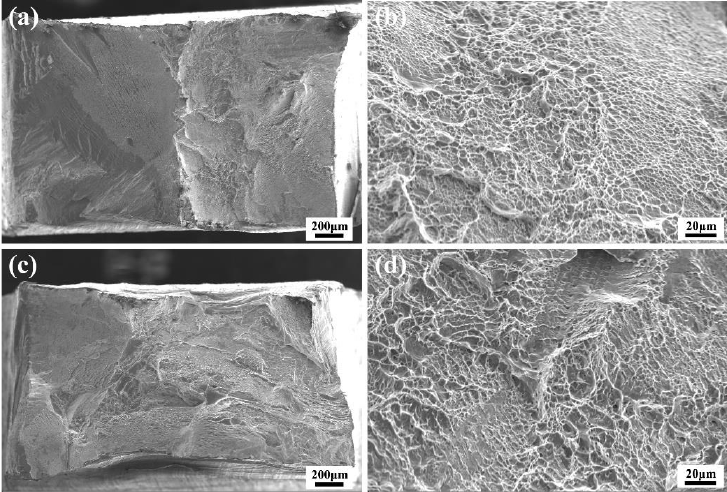
Figure 6. Fracture surfaces of the tensile specimens: ( a ) overview and ( b ) higher magnification image of the pure casting sample, ( c ) overview and ( d ) higher magnification image of the hybrid sample.